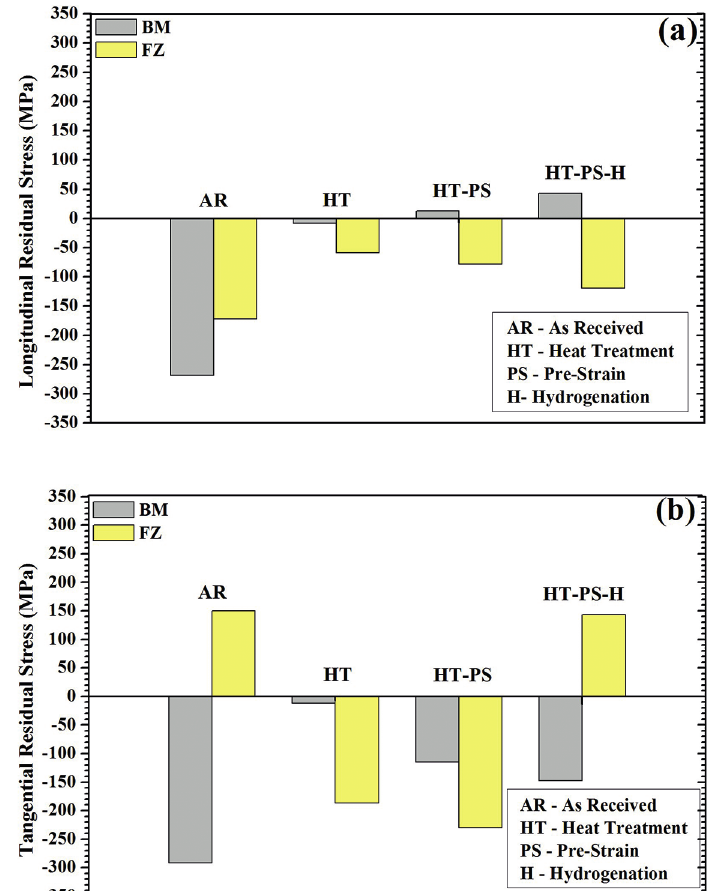
Figure 6: Longitudinal (a) and tangential (b) residual stresses in tensile pre-straining (PS) specimens of the BM material with stress relief heat treatment